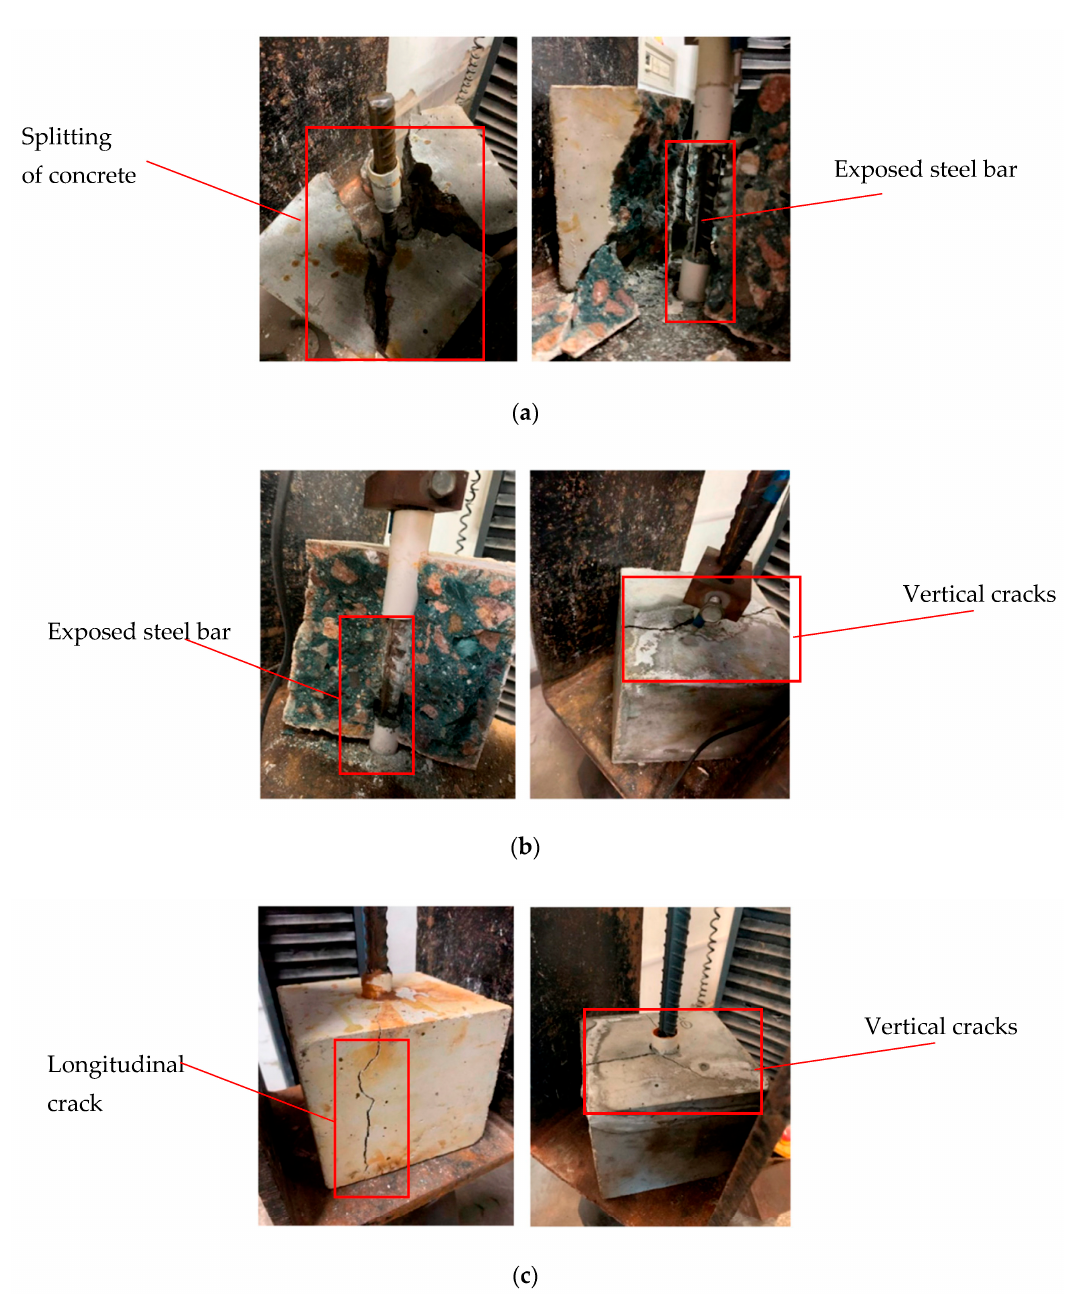
Figure 6. Failure modes of the test piece: ( a ) concrete collapse; ( b ) concrete splitting; and ( c ) pull- out